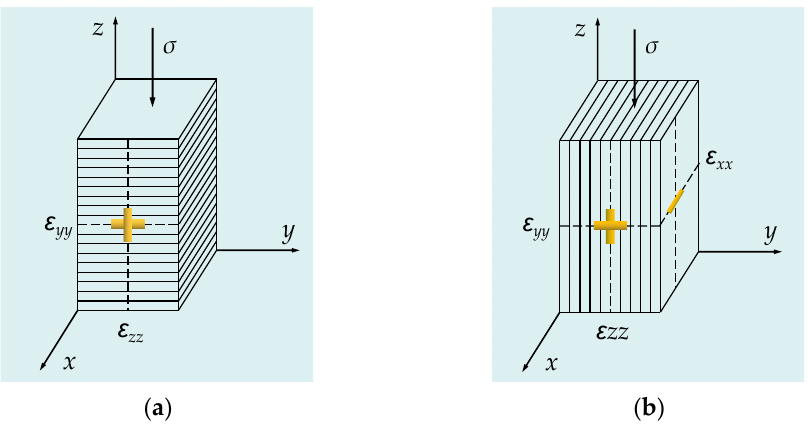
Figure 3. Stress loading method: ( a ) Vertical loading; ( b ) Parallel loading.